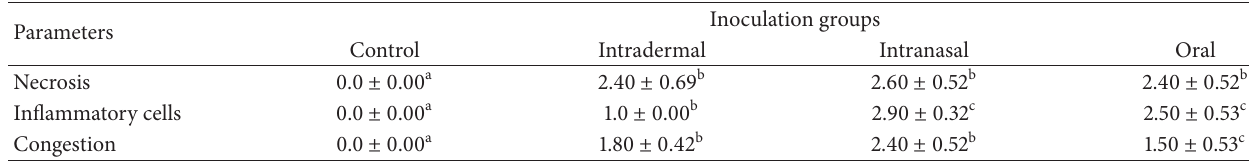
Table 1: Mean scores of histopathological changes in the ovaries of nonpregnant Boer does experimentally inoculated with C. pseudotuberculosis